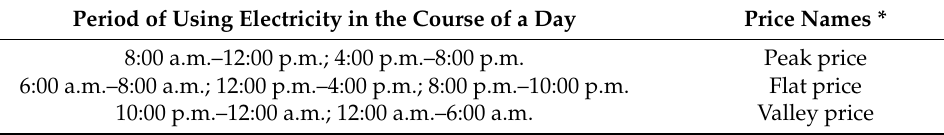
Table 1. Time-of-use electricity prices of nonresidents in Hebei Southern power grid. Period of Using Electricity in the Course of a Day